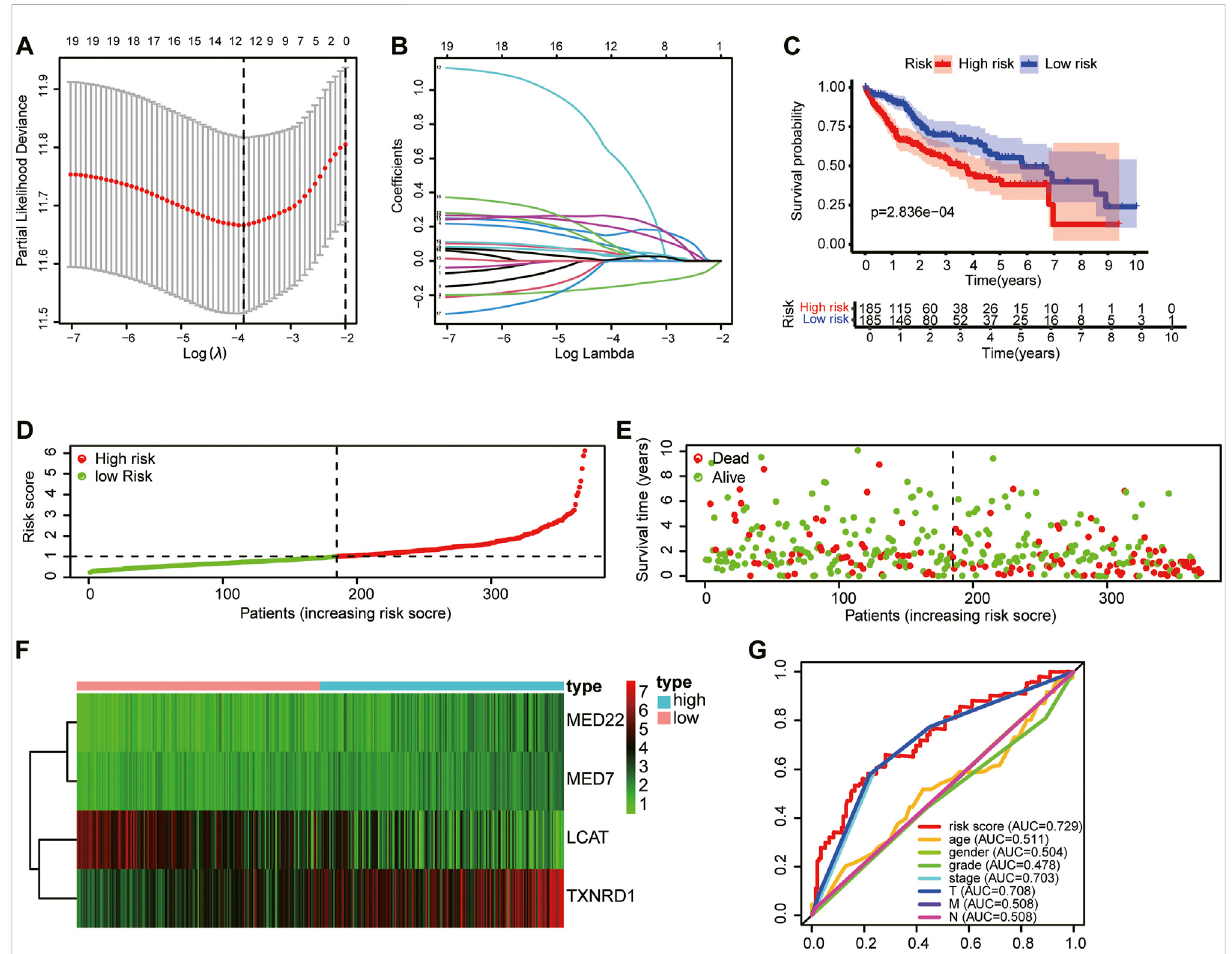
FIGURE 4 Construction of the HCC prognostic risk model based on 4 lipid metabolism-associated genes. (A) Lasso Cox regression analysis of lipid metabolism-associatedgenes. (B) Partiallikelihooddeviationfordifferentnumberofvariables. (C) Kaplan — MeiercurveofOSofhigh-riskandlow-risk HCCpatients. (D,E) Distributionofriskscore,survivalstatusofHCCpatientsandheatmapofthe4lipidmetabolism-associated genesinthehigh/low- riskgroup. (F) Theexpressionmatrixof4LMAGsincludedintheriskmodel. (G) Receiveroperatingcharacteristic(ROC)curvesofriskscores,age, gender, tumor grade and tumor